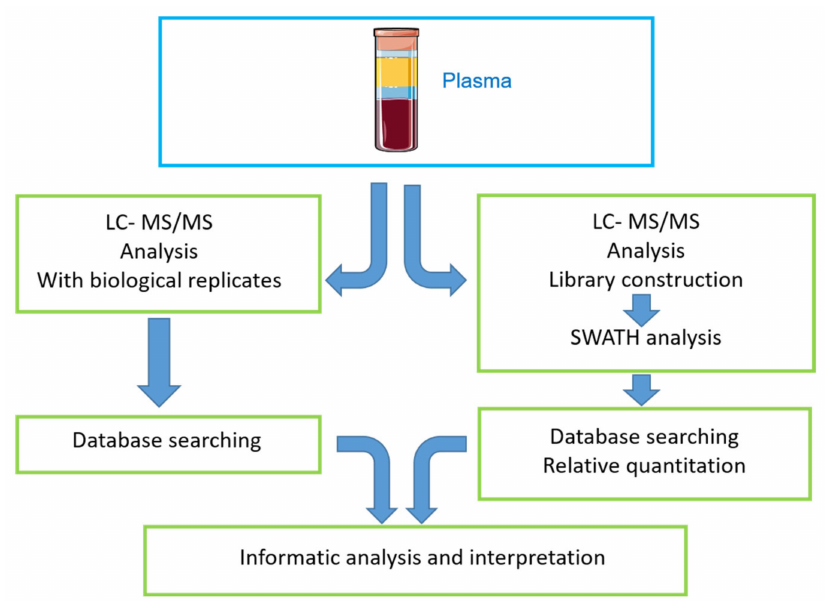
Figure 14. Graphical abstract showing study workflow. Plasma samples were acquired from 3 distinct groups: untreated MPS IVA patients; MPS IVA patients that received ERT (from whom samples were taken 1 day before and 1 day after ERT), and healthy blood donors. Blood was separated to obtain plasma, the samples were lysed, and proteomic analyses were performed. On completion of these two distinct proteomic analyses, a bioinformatics analysis was performed to obtain more information about the identified